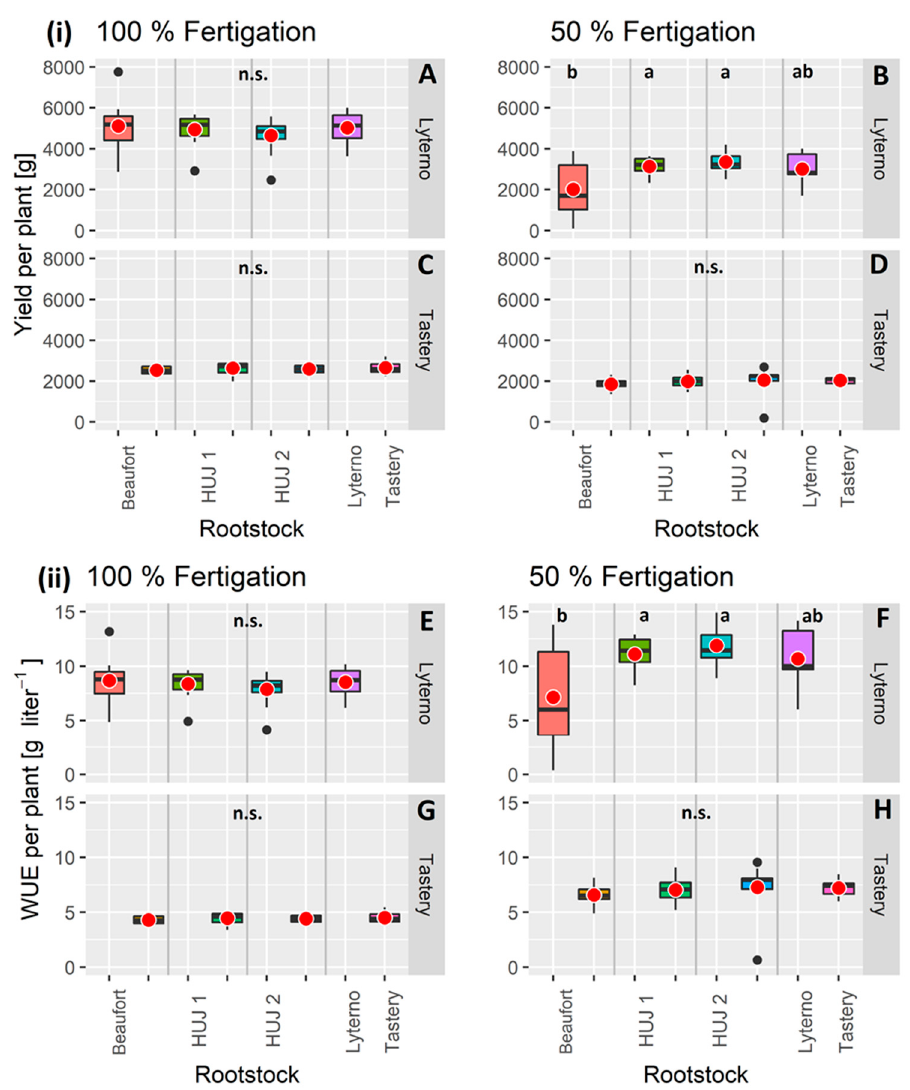
Figure 2. Average yield (( i ), top) and water-use efficiency (( ii ), bottom) per plant (n = 12) of scions from cultivar ‘Lyterno’ ( A , B , E , F ) and ‘Tastery’ ( C , D , G , H ) grafted onto different rootstocks and supplied with optimal ( A , C , E , G ) and reduced ( B , D , F , H ) fertigation. n.s.: not significant, p-value 0.05. The large standard deviations in the Lyterno yields under reduced fertigation can partly be explained through the rootstock effect: the results of an analysis of variance and subsequent Tukey’s HSD tests are presented in Table S1. Plants grafted onto Beaufort yields were significantly lower than those grafted onto HUJ 1 and HUJ 2. Self-grafted